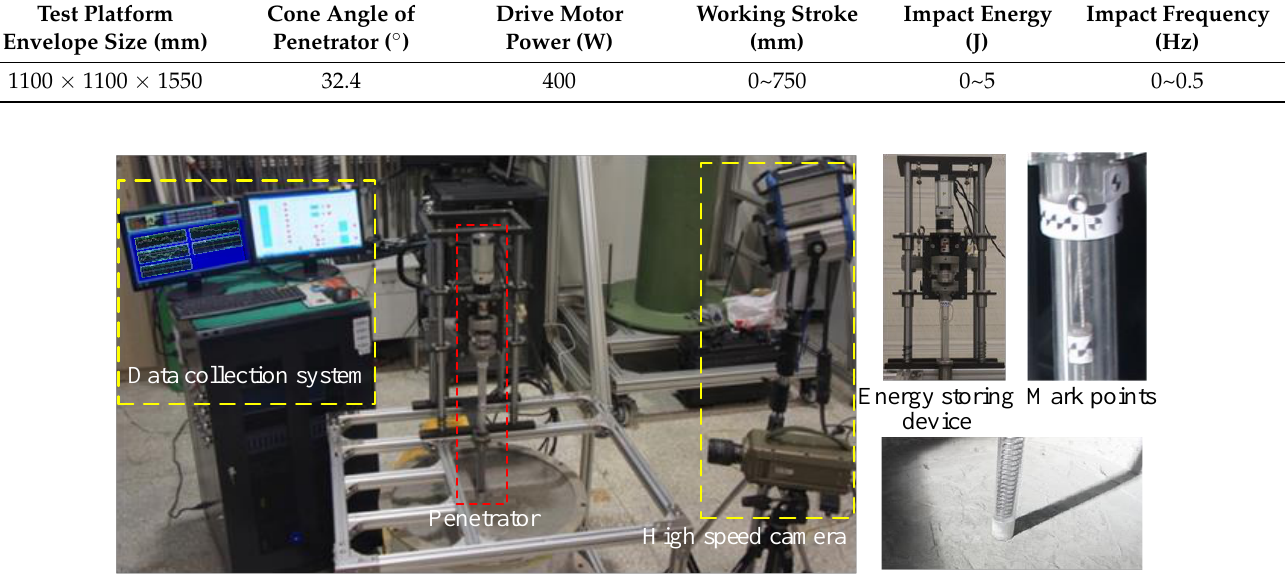
Table 8. Design parameters of the penetration test platform.